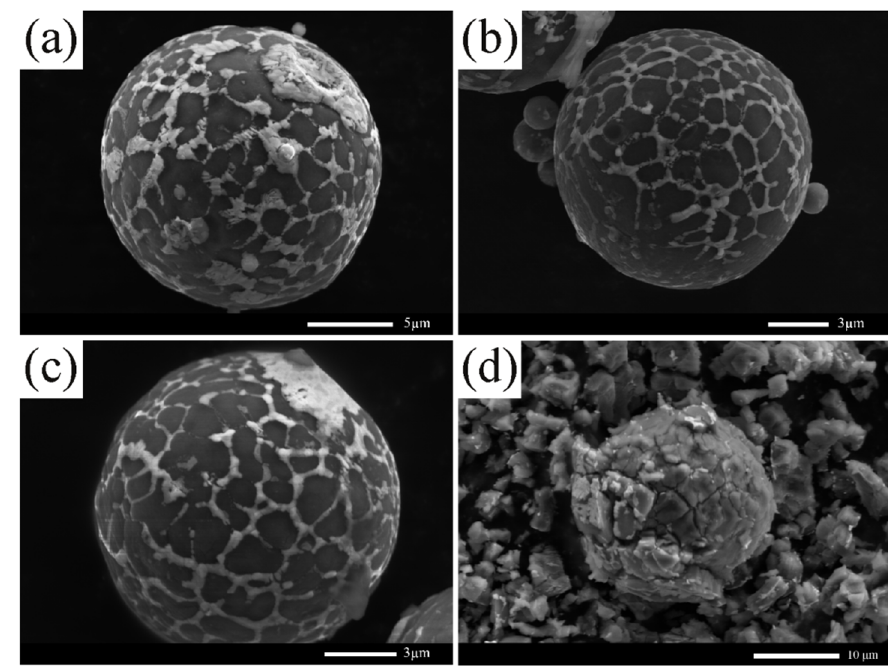
Figure 8. SEM images of the Al–10Bi–7Sn and Al–10Bi–7Sn–3Cu powders after being stored (25 °C and 60 RH%) for different time: (a) Al–10Bi–7Sn–3Cu, 6 h, (b) Al–10Bi–7Sn–3Cu, 12 h, (c) Al–10Bi–7Sn–3Cu, 24 h, (d) Al–10Bi–7Sn, 12h.